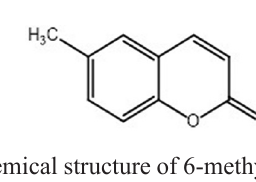
FIGURE 1 - Chemical structure of